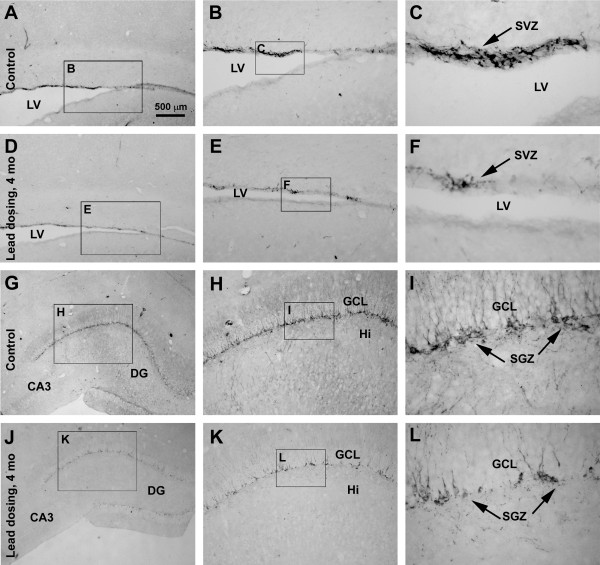
Representative data showing doublecortin-immunoreactive (DCX+) cells in the subventricular zone (SVZ) (A-F) and subgranular zone (SGZ) (G-L) in age-matched control (A-C; G-I) compared to Pb-treated (D-F; J-L) animals surviving 4 months. Framed areas in left panel images are sequentially enlarged as middle and right panel images. Scale bar in (A) = 200 μm applying to left panels; equal to 200 μm for middle panels and 50 μm for right panels.